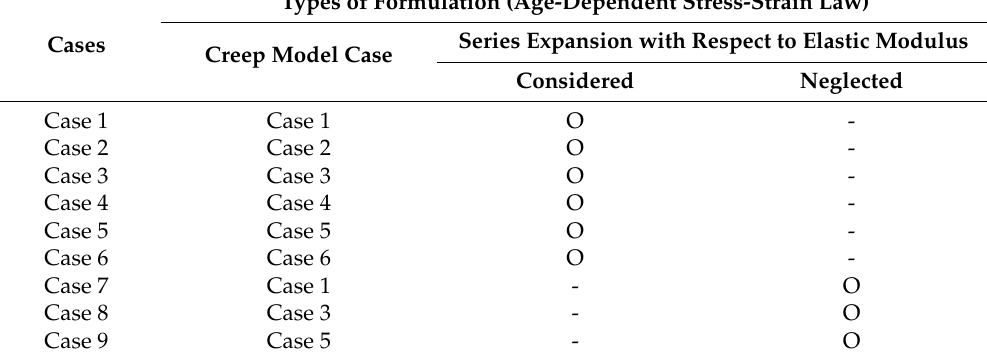
Table 3. Characteristics of the nine constitutive